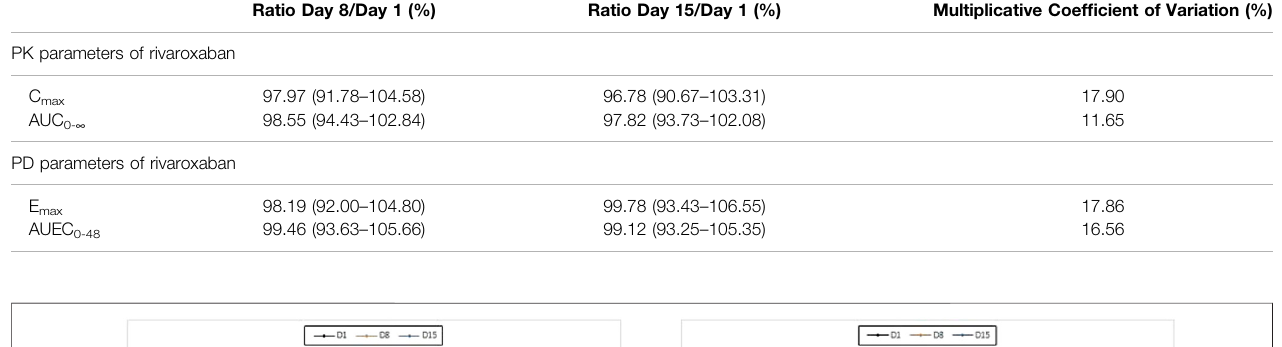
TABLE2| Geometricmeanratio(90%con fi denceinterval)ofPKandPDparametersaftersingle(Day8)orrepeatedintakeof240 mgEGb761 ® (Day15)relativetotheintake of rivaroxaban alone (Day 1).